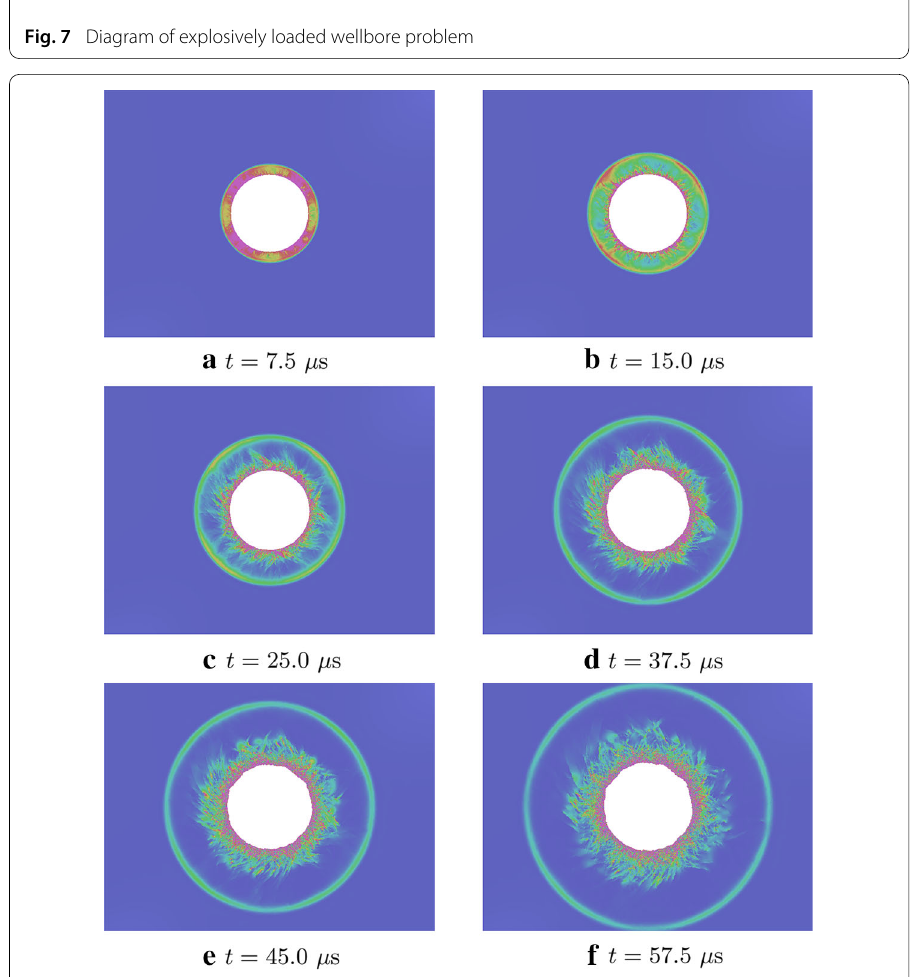
Fig. 8 Solution visualization sequence for explosively loaded wellbore